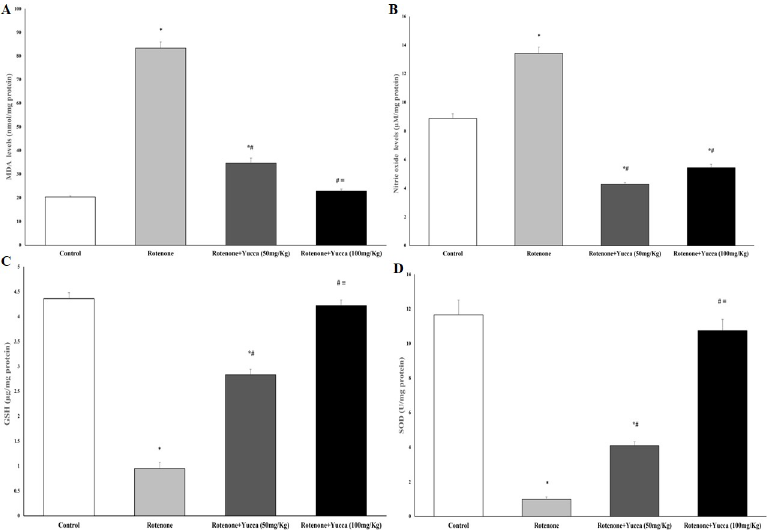
Fig 6. Effect of rotenone and its cotreatment with yucca extract on oxidative and antioxidative stress markers. A, B : cotreatment of yucca extract with rotenone decreased MDA and nitric oxide. C, D : increased GSH and SOD in rats’ striatum. Data are represented as the mean ± SEM of eight animals in each group. ( � ) Significantly differs ( P < 0.05) compared to control group; (#) significantly differs ( P < 0.05) compared to rotenone alone treated group; ( � ) significantly differs ( P < 0.05) compared to rotenone + yucca (50mg/kg) treated group.